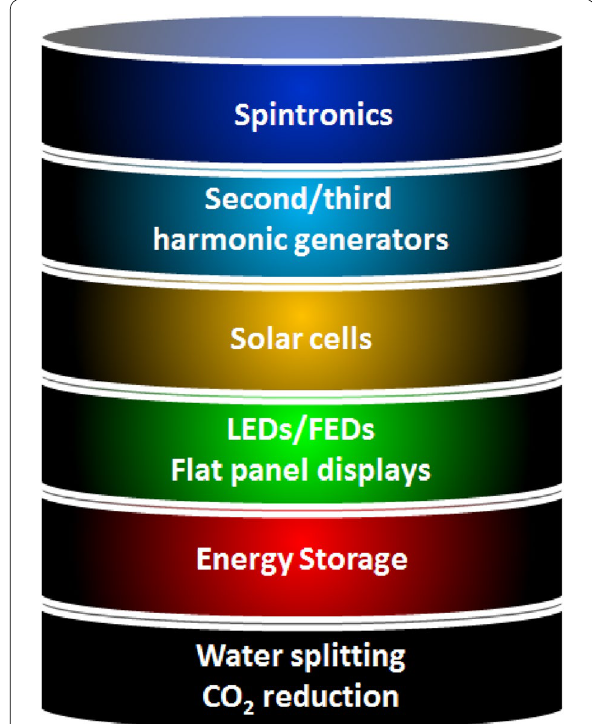
Fig. 15 Futuristic applications of 2D materials, doped 2D materials, and their hetero